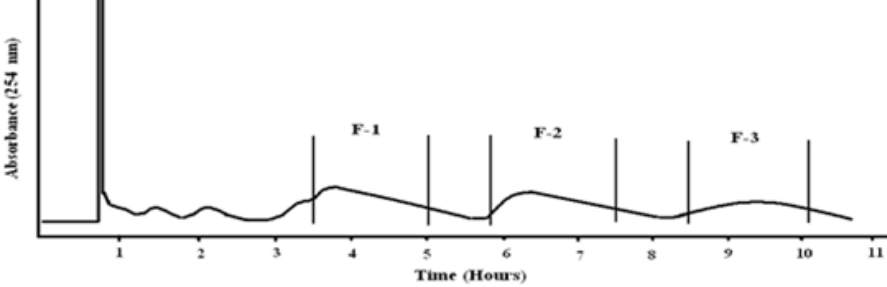
Figure 1: HSCCC separation 1 of theaflavin crude extract from black tea (254 nm), Solvent system Hex:EtOAC:MeOH:water (1:4:1:4), elution 2.8 ml/min, 1000rpm, sample size 200mg